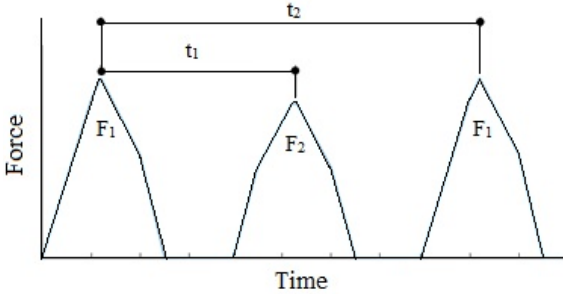
Figure 22. Variation of the vertical force acting at the shoe.